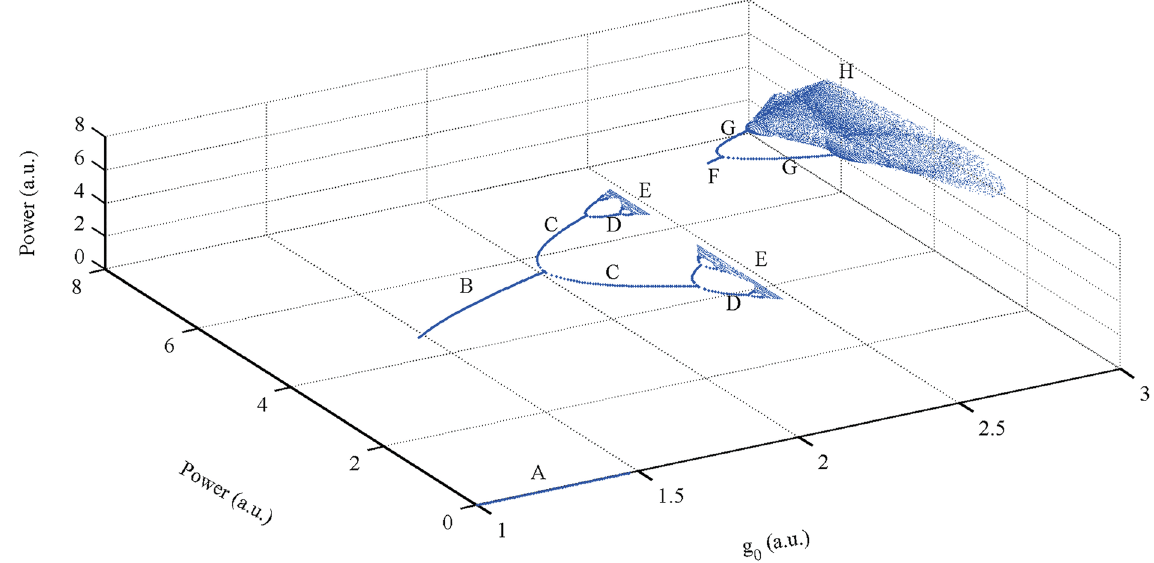
Figure 3. Bifurcation orbit diagram in multi-dimensional phase space under certain initial conditions with different gain coefficient g 0 . Point A (1 < g 0 < 1.46), there is no pulse; point B (1.46 < g 0 < 2.02), stable single pulse state; point C (2.02 < g 0 < 2.32) and D (2.32 < g 0 < 2.40), single pulse with periodic fluctuations; point E (2.43 < g 0 < 2.47), single pulse that exhibits chaotic fluctuation; point F (2.47 < g 0 < 2.53), stable double pulse state; point G (2.53 < g 0 < 2.74), double pulse with periodic fluctuations; point H (g 0 > 2.82), chaotic